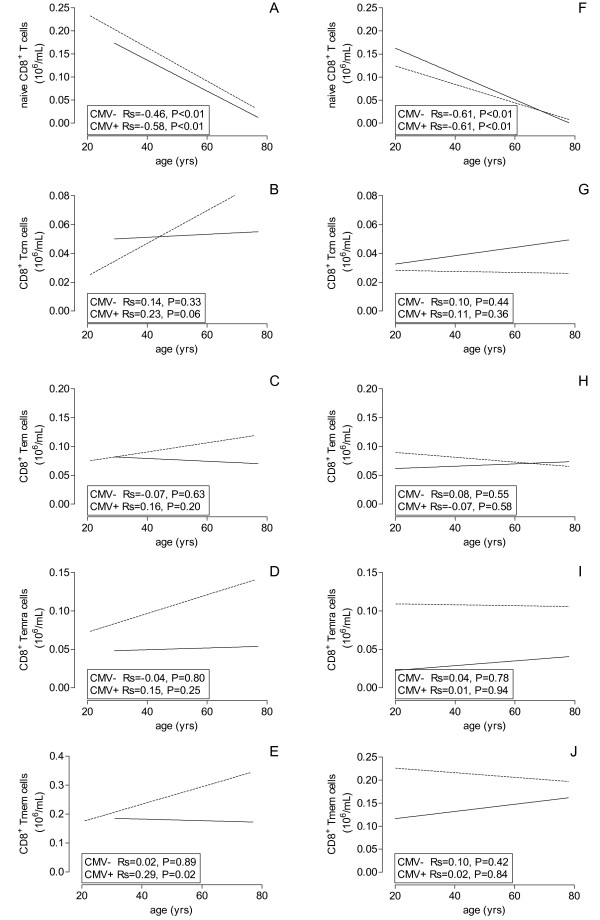
Age-related effects of CMV on CD8+ T cell subsets. The lines of the best fits are shown for absolute numbers of CD8+ Tnaive (A, F), Tcm (B, G), Tem (C, H), Temra (D, I) and Tmem (E, J) of healthy volunteers (A, B, C, D, E) and ESRD patients (F, G, H, I, J) against age on X-axis and CMV serostatus (dotted line = CMV seropositive and closed line = CMV seronegative).